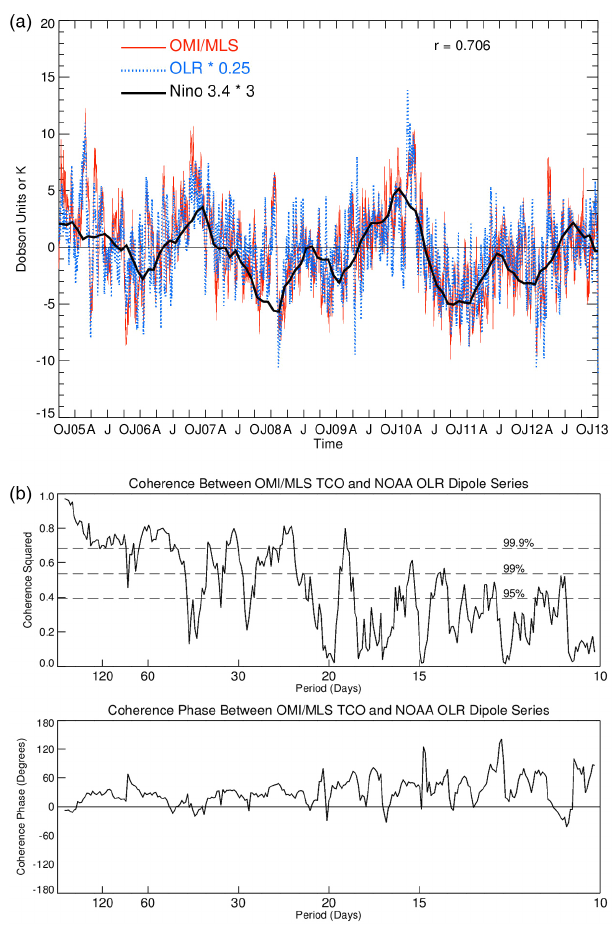
Figure 4. This figure plots ODI and OLR dipole time series in (a) followed by calculated coherence and phase of coherence between OLR and OMI/MLS ODI in (b) . Panel (a) is similar to Fig. 2a ex- cept with calculated OLR dipole series (blue dashed curve) replac- ing the CTM ODI. OLR time series values have been divided by 4 for plotting with ozone. Panel (b) is similar to Fig. 3a except that the calculated coherence and coherence phase is between the OMI/MLS ODI and OLR dipole